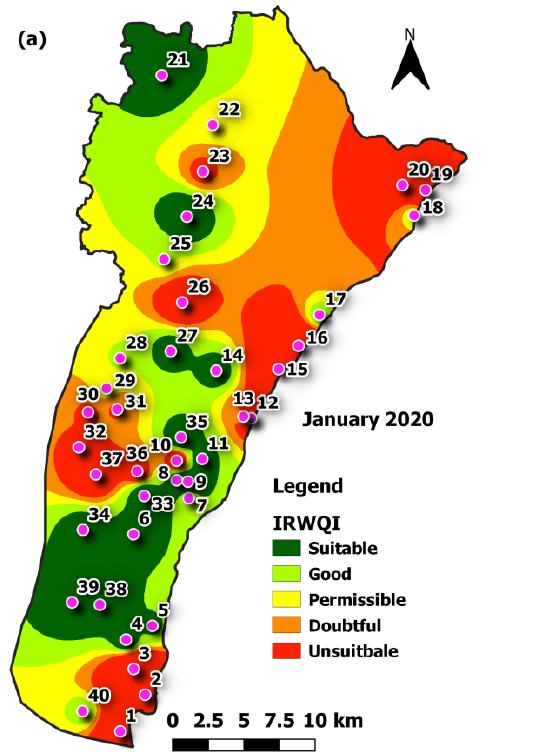
Figure 7. Spatial distribution maps of the calculated IRWQI for ( a ) January 2020 and ( b ) January 2021.